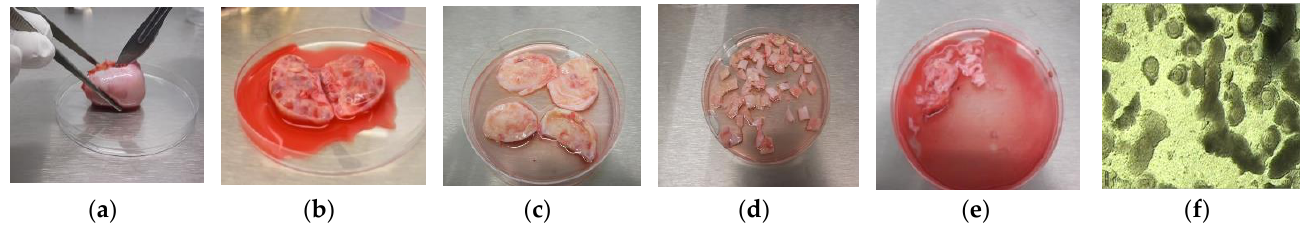
Figure 1. Ovarian tissue preparation for cryopreservation: ( a ) Bisection of the ovary; ( b ) Bisected ovary with antral follicles displayed in the medulla; ( c ) Cortical tissue of which the medulla is removed; ( d ) Cortical tissue pieces ready for cryopreservation; ( e ) Residual medulla after it has been mechanically scraped from the cortical tissue; ( f ) Microscopic view of the Petri dish ( e ) showing cumulus–oocyte complexes.